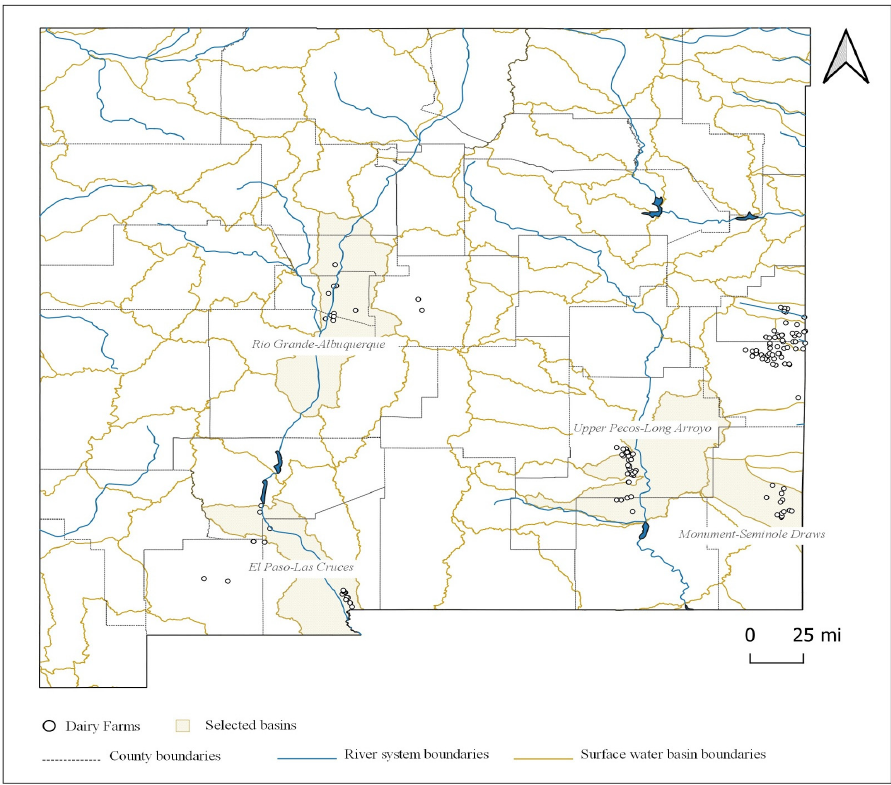
Figure 3. Surface water basins in New Mexico.